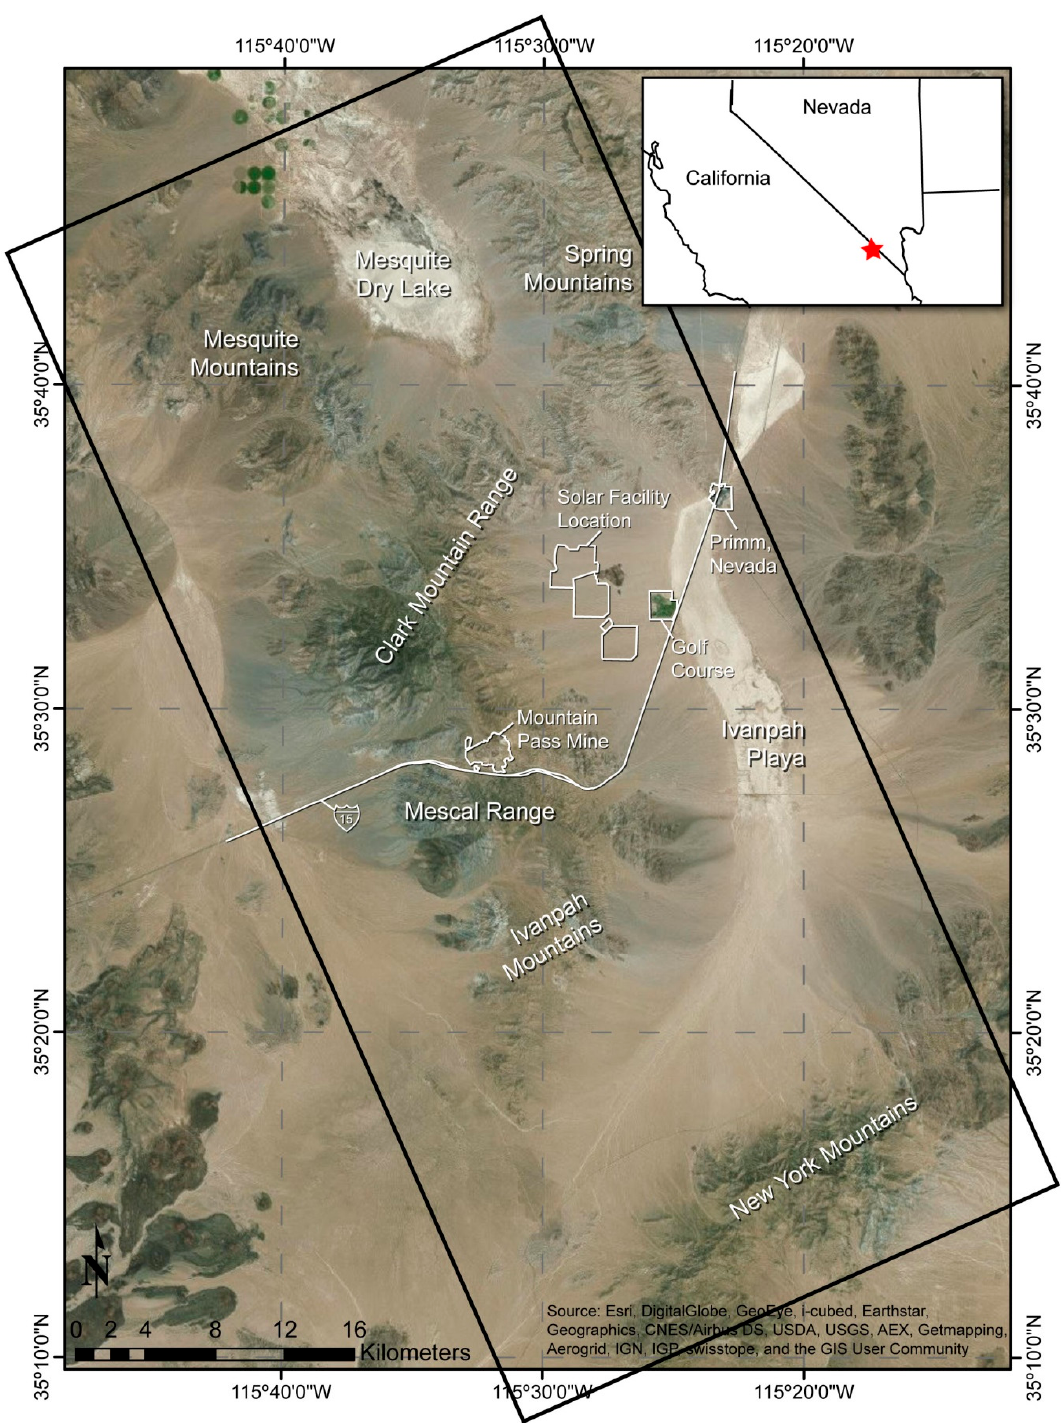
Figure 1. The region near Mountain Pass, California. The basemap image is from the ArcGIS Online World Imagery basemap by Esri. The solid black outline gives the approximate extent of the study area covered by the spectral imagery. Significant terrain features are labeled. Note that the Solar Facility location is marked but not visible in the image, which was acquired pre-construction.